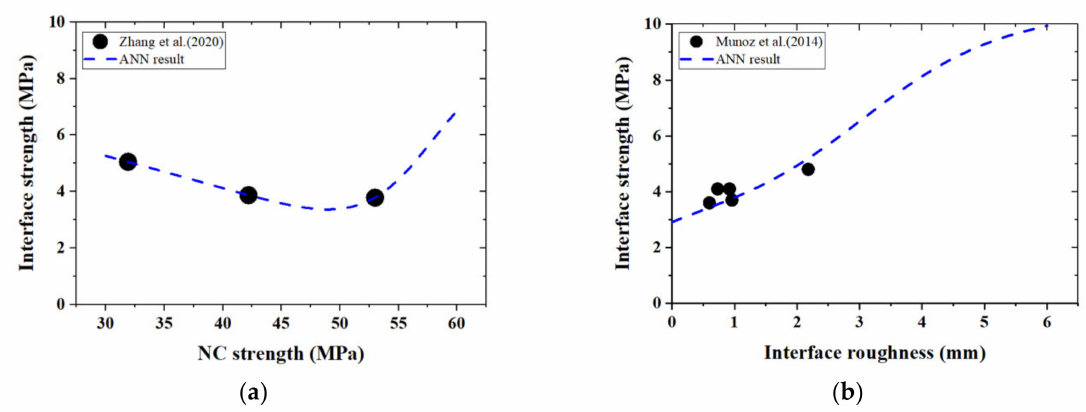
Figure 9. Influence of factors on adhesion. ( a ) Effect of f NC ; ( b ) effect of R